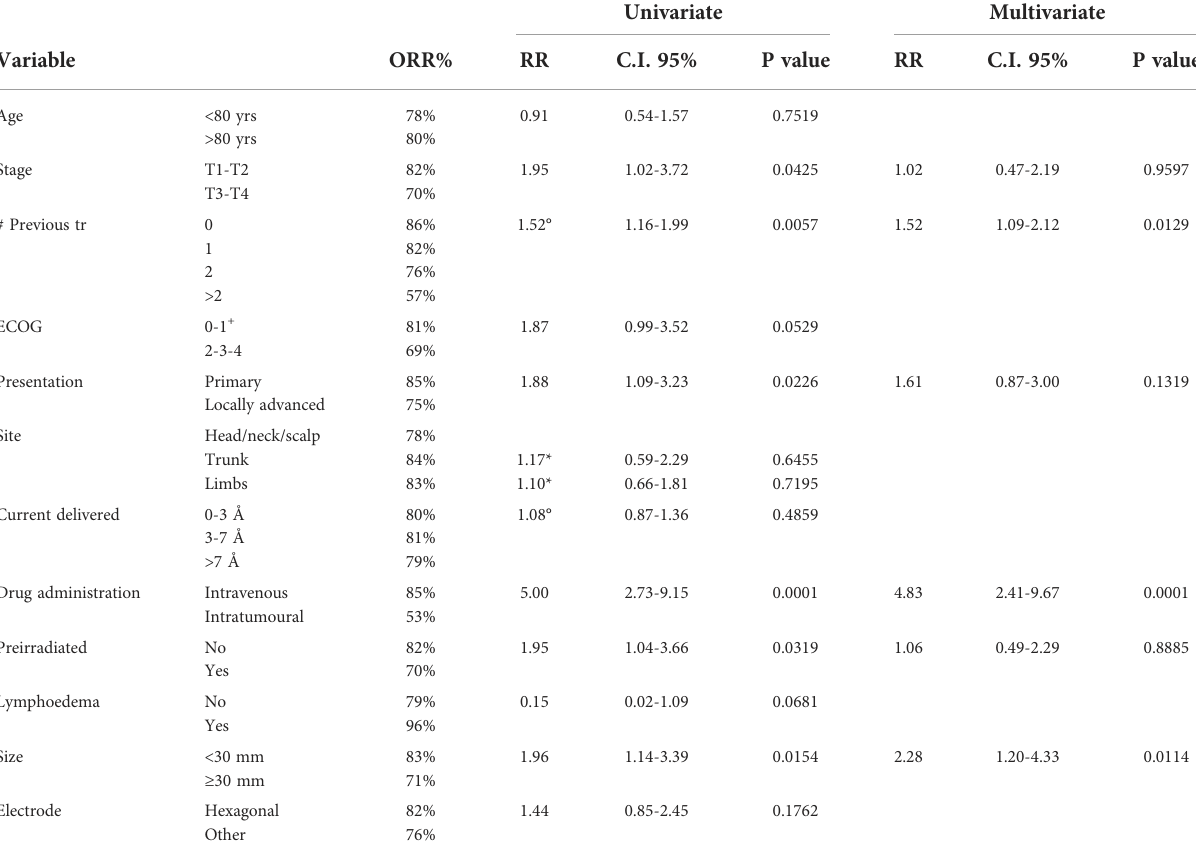
TABLE 2 Factors affecting the overall response rate: univariate and multivariate analyses.